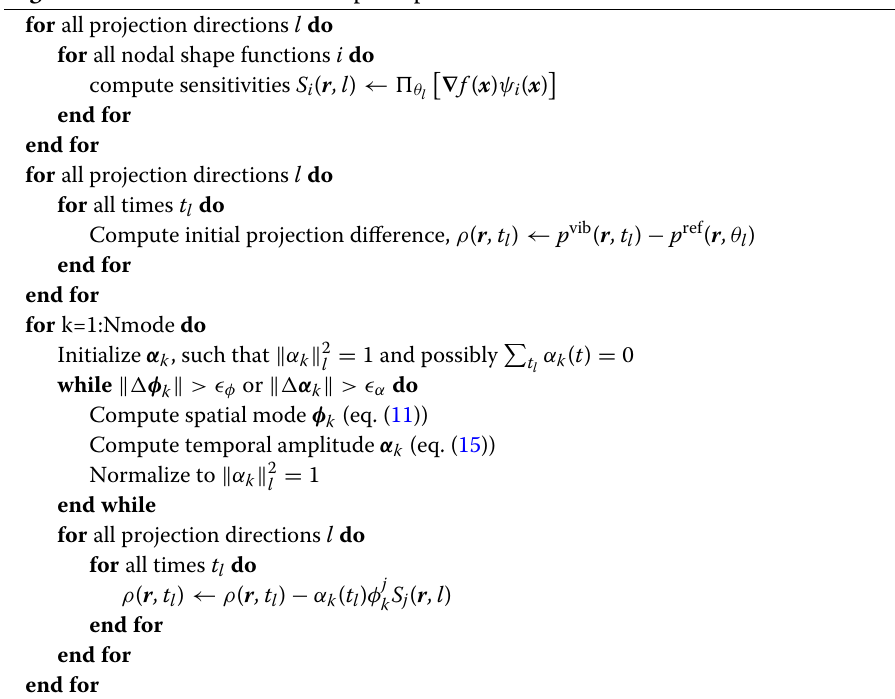
Algorithm 1 Modal P-DVC fixed-point